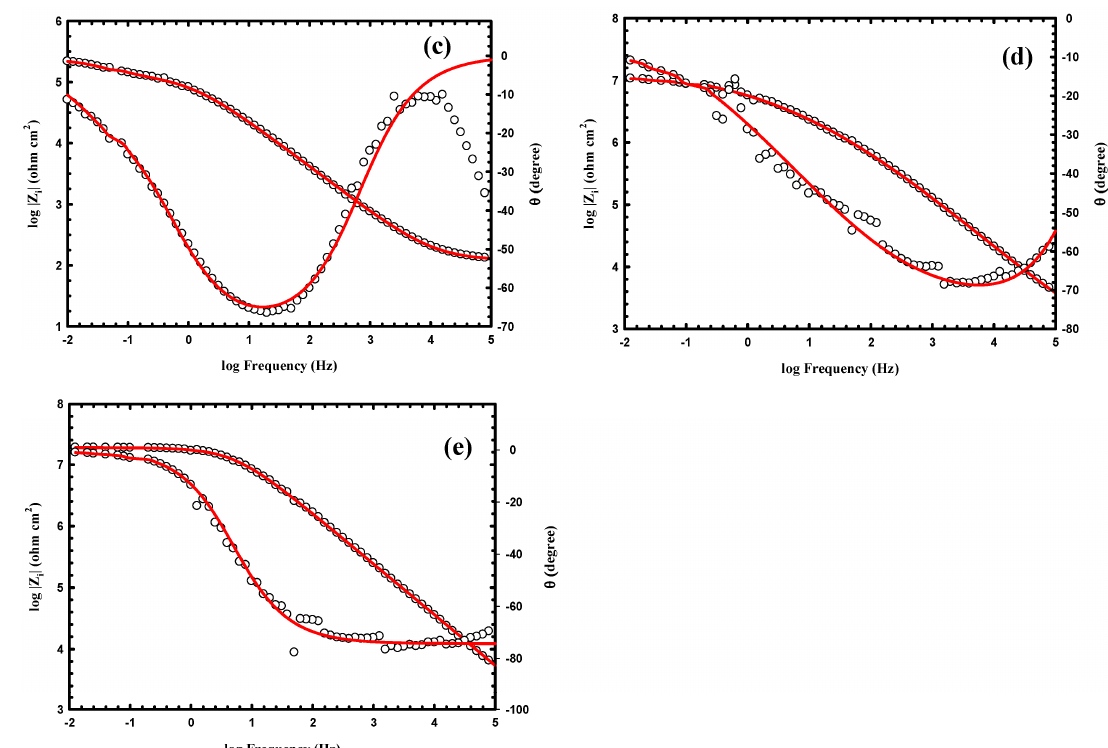
Figure 8. Bode plots of the ( a ) uncoated Al alloy ( b ) PS1, ( c ) PS3, ( d ) PA1, and ( e ) PA3 from the EIS measurements in 3.5 wt % NaCl.